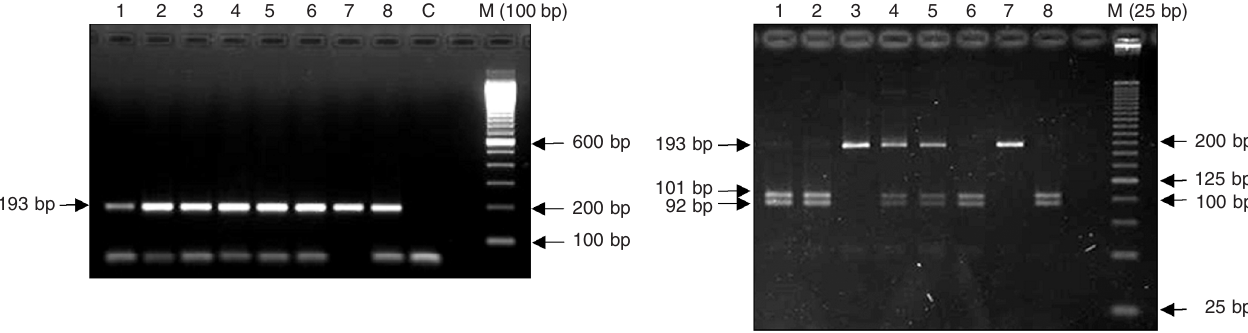
Figure 1 . WRN :1367 gene polymorphism. A , PCR amplification products on 2% agarose gel. Lanes 1-8 (PCR products), C (negative control) and M (DNA marker, 100 bp). B , Restriction fragment length polymorphism on 4% GTG agarose gel. Lanes 1, 2, 6, and 8 , R allele and RR genotype (~101 + ~92 bp); lanes 3 and 7 , C allele and CC genotype (~193 bp), and lanes 4 and 5 , CR genotype (~199 + ~113 + ~86 bp) and M (DNA marker, 25